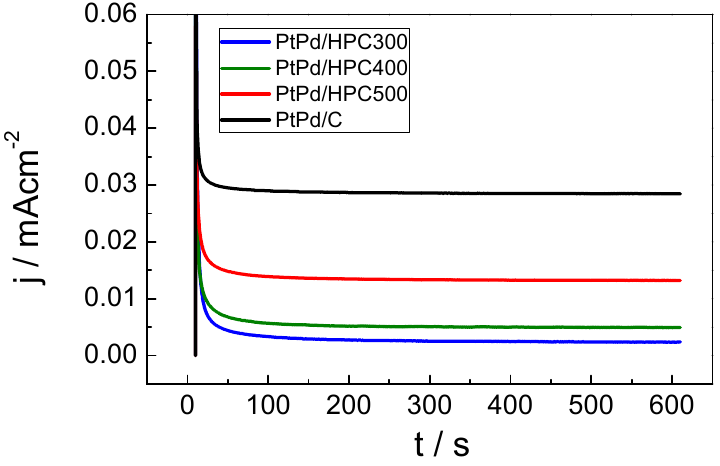
Figure 7. Chronoamperometric curves in terms of current density for PtPd/HPC300, PtPd/HPC400, PtPd/HPC500 and commercial catalyst recorded at 0.55 V CH OH + 0.5 M H SO ; 25 3 2 4